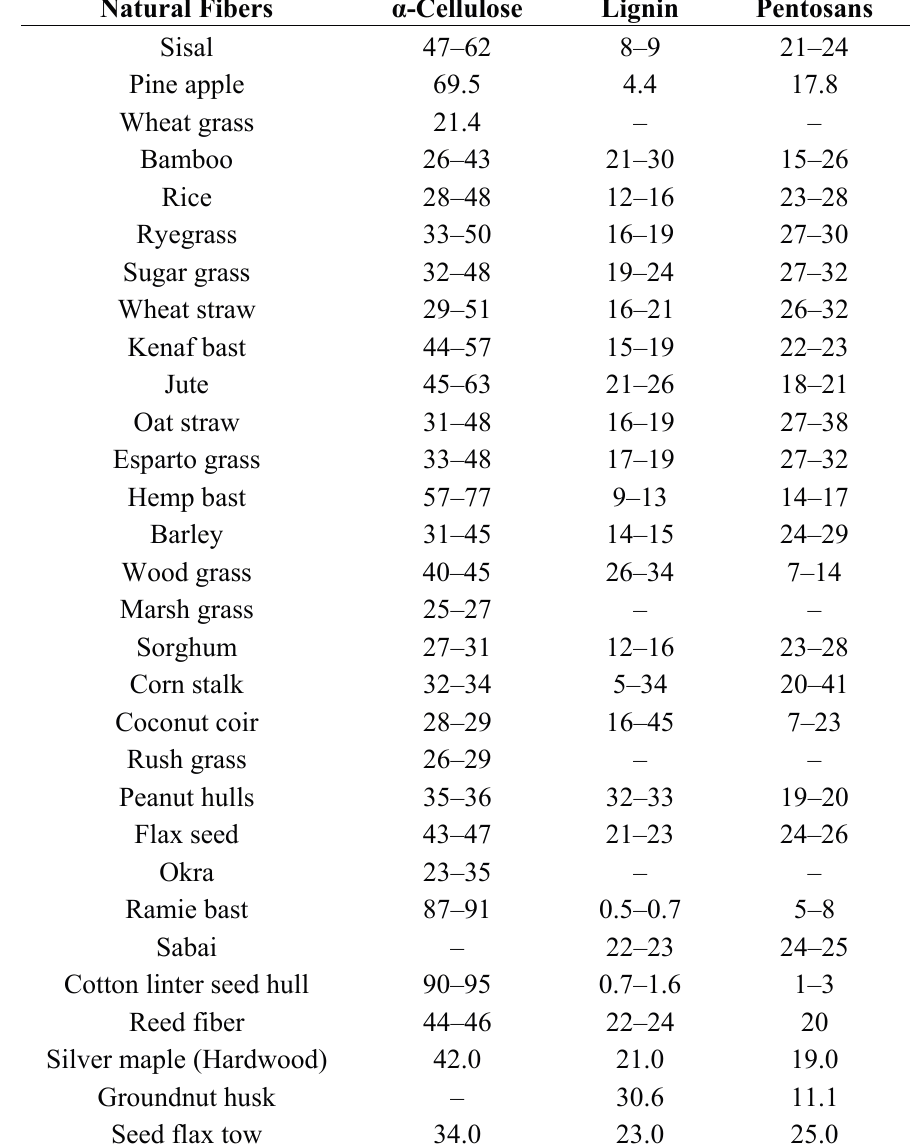
Table 2. Chemical compositions of some important natural fibers. Reprinted with permission from Elsevier, 2008